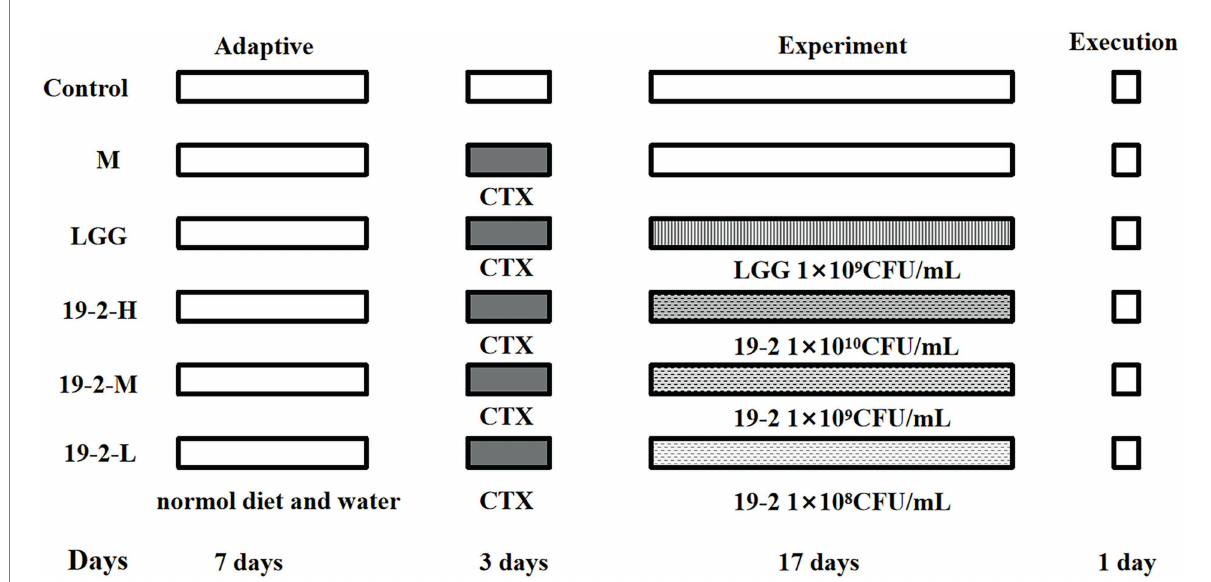
FIGURE 1 Experimental design of this study. Control group: intraperitoneal injection of saline, days 1–3 and oral saline, days 4–20; M group: intraperitoneal injection of cyclophosphamide, days 1–3; LGG group: fed with Lactiplantibacillus rhamnosus 1 × 10 9 CFU/ml, days 4–20 and intraperitoneal injection of cyclophosphamide, days 1–3; 19-2-H group: fed with Lactiplantibacillus plantarum 19-2 1 × 10 10 CFU/ml, days 4–20 and intraperitoneal injection of cyclophosphamide, days 1–3; 19-2-M group: fed with Lactiplantibacillus plantarum 19-2 1 × 10 9 CFU/ml, days 4–20 and intraperitoneal injection of cyclophosphamide, days 1–3; 19-2-L group: fed with Lactiplantibacillus plantarum 19-2 1 × 10 8 CFU/ml, days 4–20 and intraperitoneal injection of cyclophosphamide, days